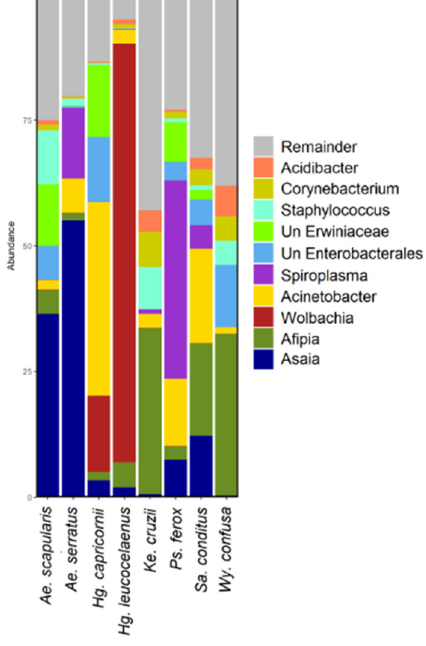
Figure 1. Bar graph depicting the bacterial amplicon sequence variants (ASV) composition at the highest taxonomic level (phylum) for each mosquito species.